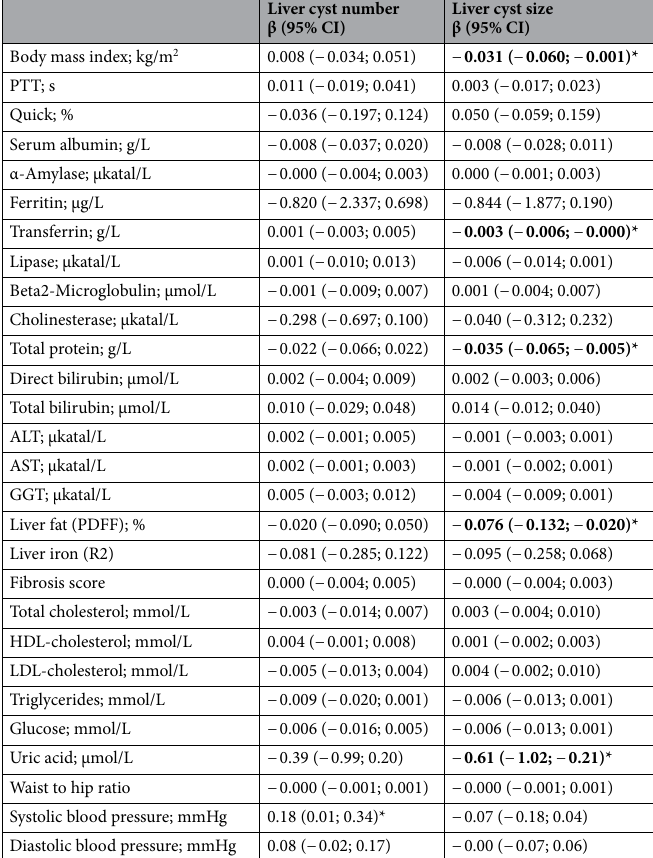
Table 2. Associations of liver cyst number and size with selected markers from laboratory and MRI; β’s are derived from linear regression models adjusted for age and sex with the respective marker as outcome and liver cyst number and size as exposures. Significant results are given in bold letters. CI = confidence interval; * p < 0.05; PTT – partial thromboplastin time; ALT – alanine transaminase; AST – aspartate transaminase; GGT – gamma-glutamyltransferase.